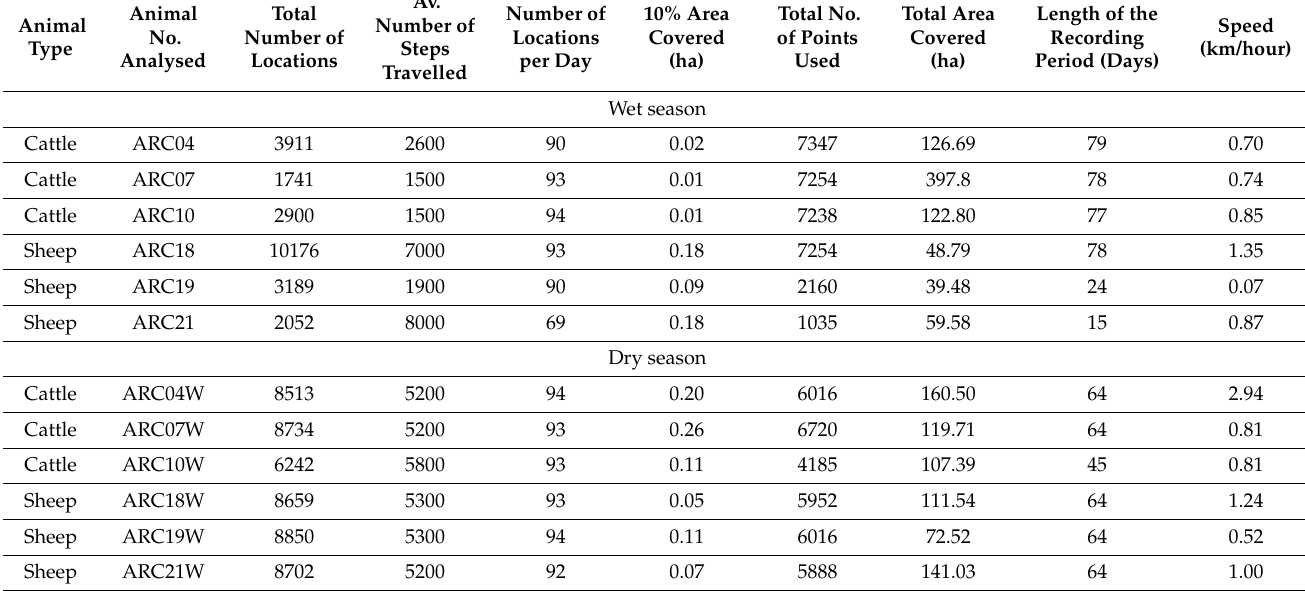
Table 1. Livestock distribution by the number of locations over time during the wet and dry